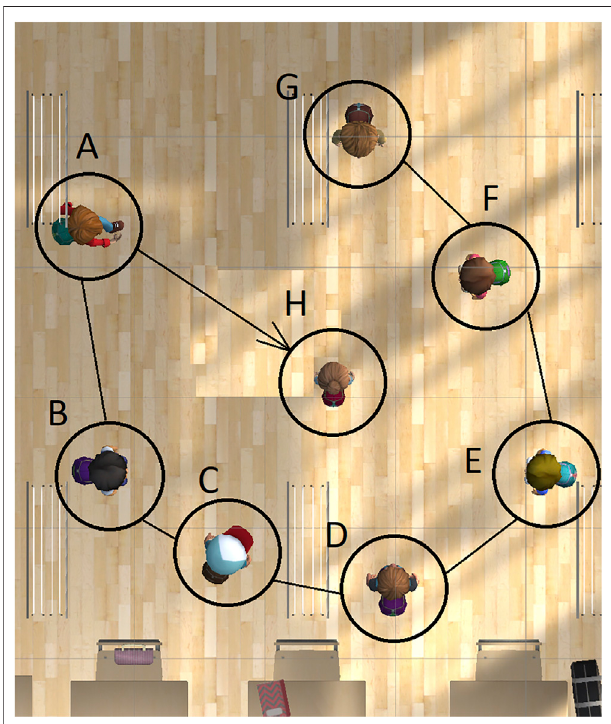
FIGURE 2 | Positioning of students at the beginning of the